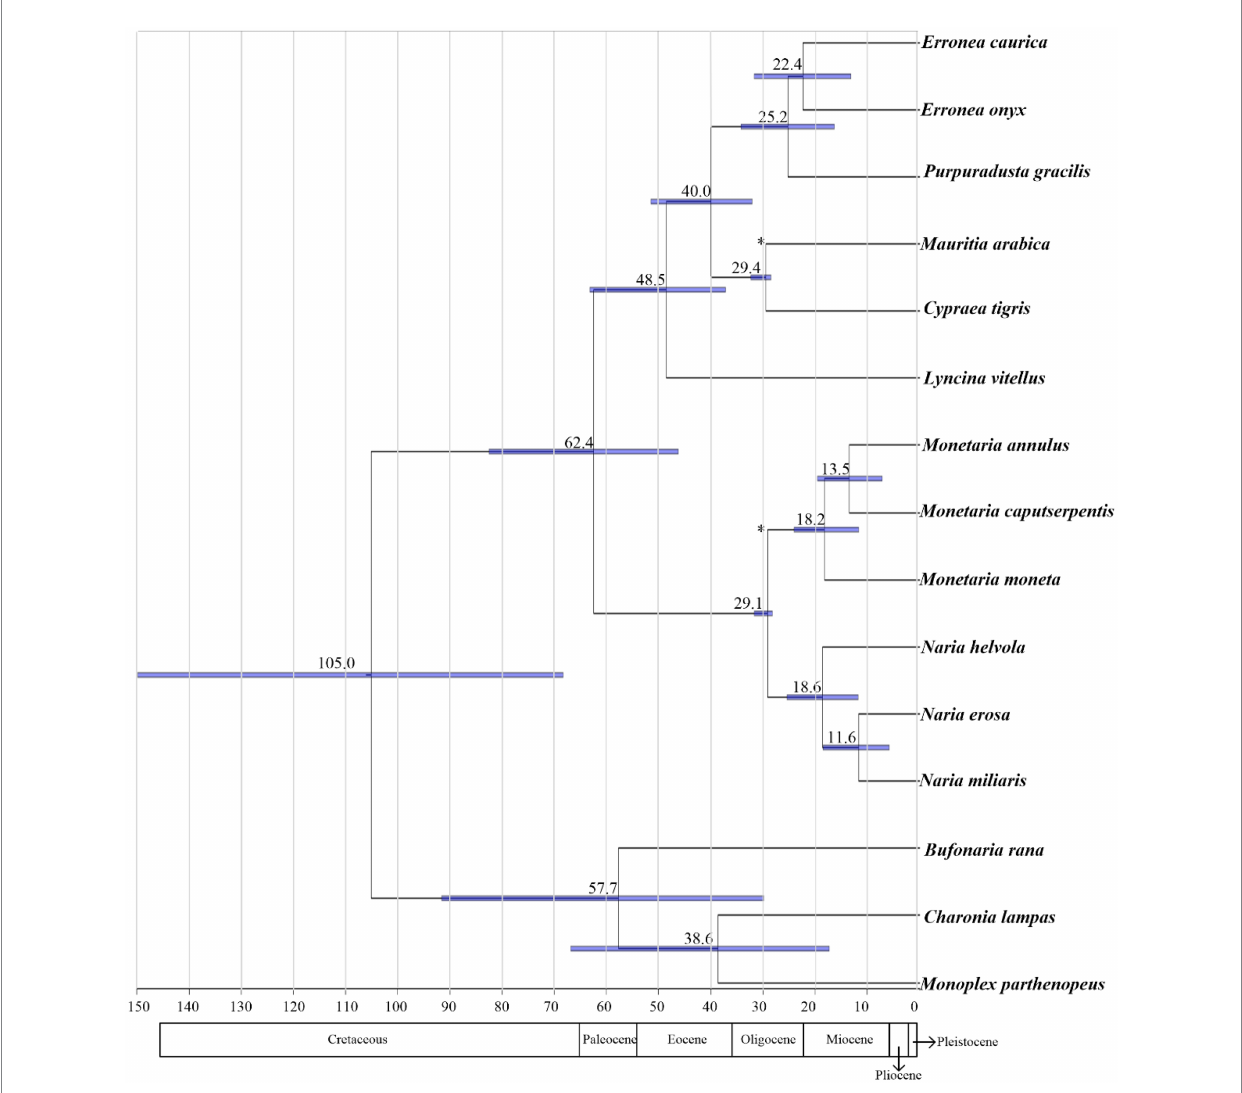
FIGURE 7 Divergences time estimations for the Cypraeidae using Bayesian relaxed dating methods (BEAST). Dates (and credibility intervals) are in millions of years, and horizontal bars represent 95% credibility intervals of relevant nodes.